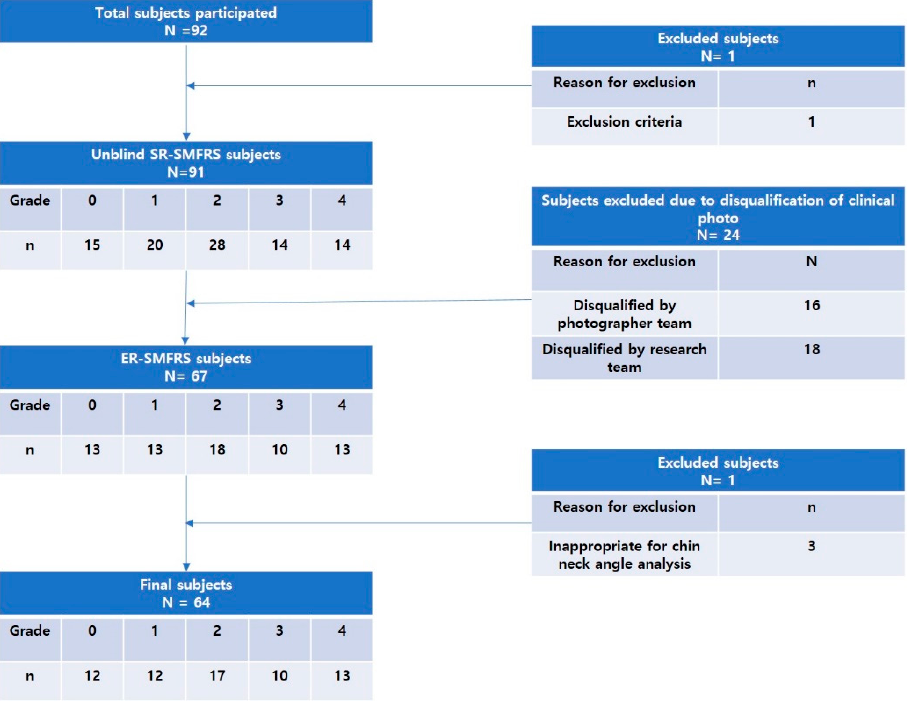
Figure 4. Flowchart of subjects enrolled in the trial. Table 3. Patient factor with respect to